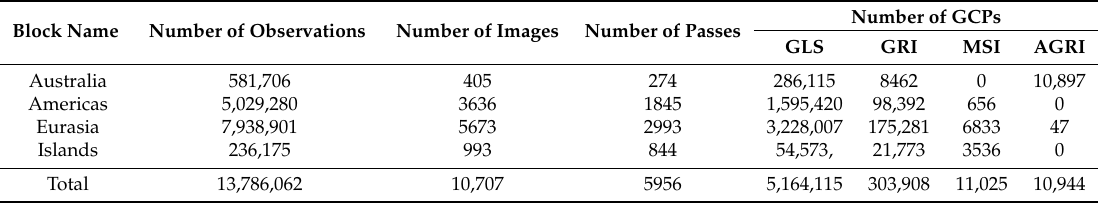
Table 4. Number of observations, passes, images, and GCPs used for each triangulation block in the space-based bundle adjustment procedure.